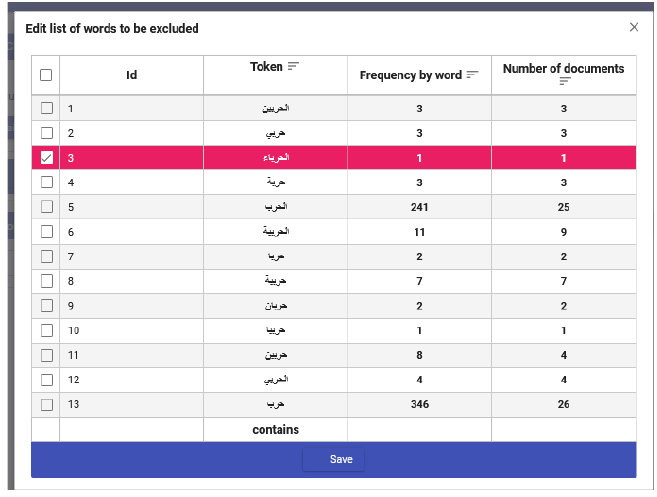
Figure 8. Two lists of selected words to be excluded from the frequency report as they differ in meaning from the search term.